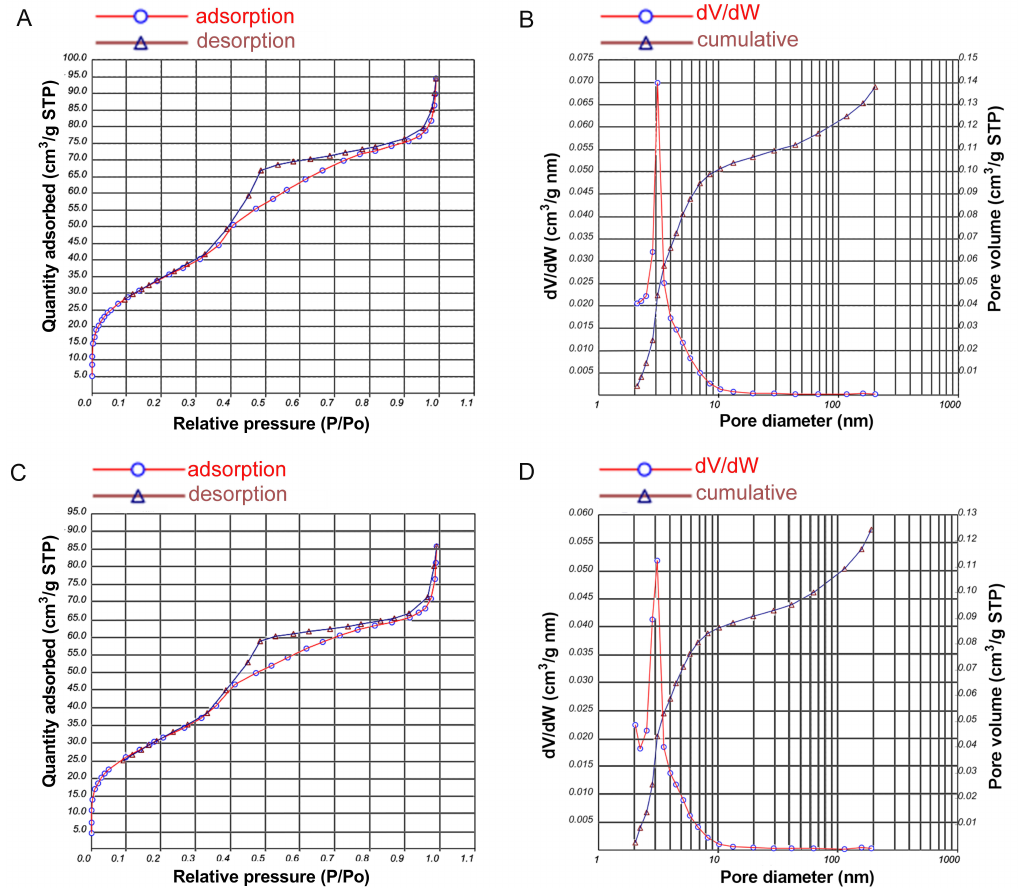
Figure 2. Nitrogen adsorption-desorption isotherm test and pore size distribution of MCSNs and M-AgTX. ( A , C ) Nitrogen adsorption-desorption isotherm test of MCSNs and M-AgTX, respectively; ( B , D ) Pore size distribution of MCSNs and M-AgTX, respectively.